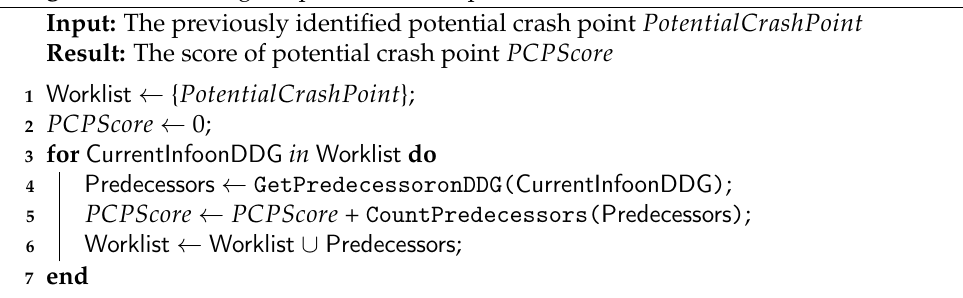
Algorithm 1: Scoring the potential crash